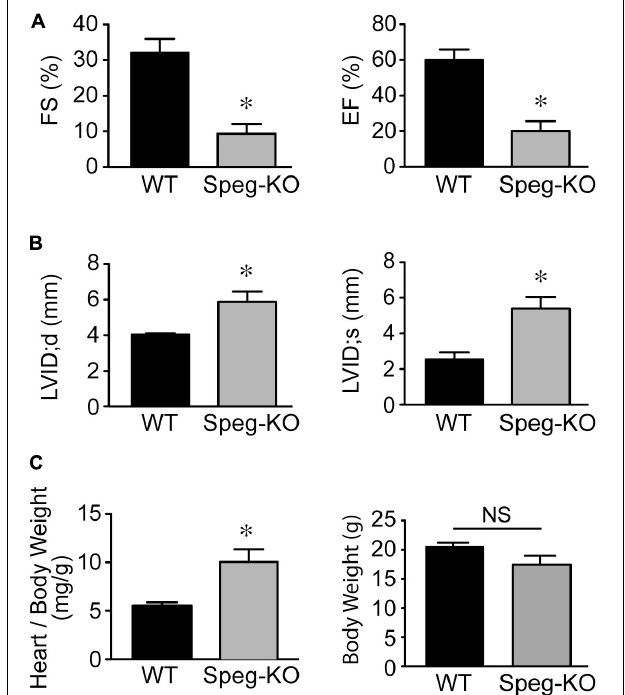
FIGURE 2 | Dilated cardiomyopathy in adult Speg striated muscle-specific KO mice. Echocardiographic assessment of Speg wild type (WT, black bar, n = 4) and striated muscle specific null (KO, gray bar, n = 4) mice from 6 to 12 weeks of age. (A) Left ventricular fractional shortening (FS, %) and ejection fraction (EF, %). (B) Left ventricular internal diameter (LVID, mm) in diastole and systole. Following echocardiography, mice were sacrificed, and heart and body weight were measured. (C) Ratio of heart to body weight (mg/g, left panel) and total body weight (g, right panel). For (A–C) , analysis performed